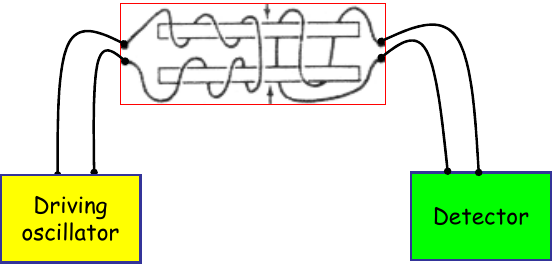
Figure 123: Outline of a flux-gate magnetometer. The driving oscillator makes an electric current, at frequency 𝑓 , circulate along the coil. This coil is such to induce along the two bars a magnetic field with the same intensity but opposite direction so that the resulting magnetic field is zero. The presence of an external magnetic field breaks this symmetry and the resulting field ̸ = 0 will induce an electric potential in the secondary coil, proportional to the intensity of the component of the ambient field along the two